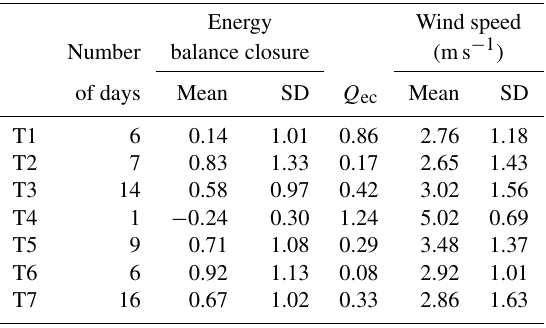
Table 3. Statistics on energy balance closure, error in energy bal- ance closure ( Q ec ), and wind speed during energy balance closure analysis periods for each synoptic